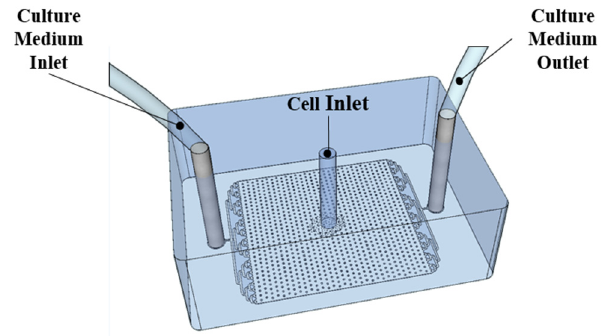
Figure 2. Micro fl uidic chamber for cell culture. Figure 2. Microfluidic chamber for cell